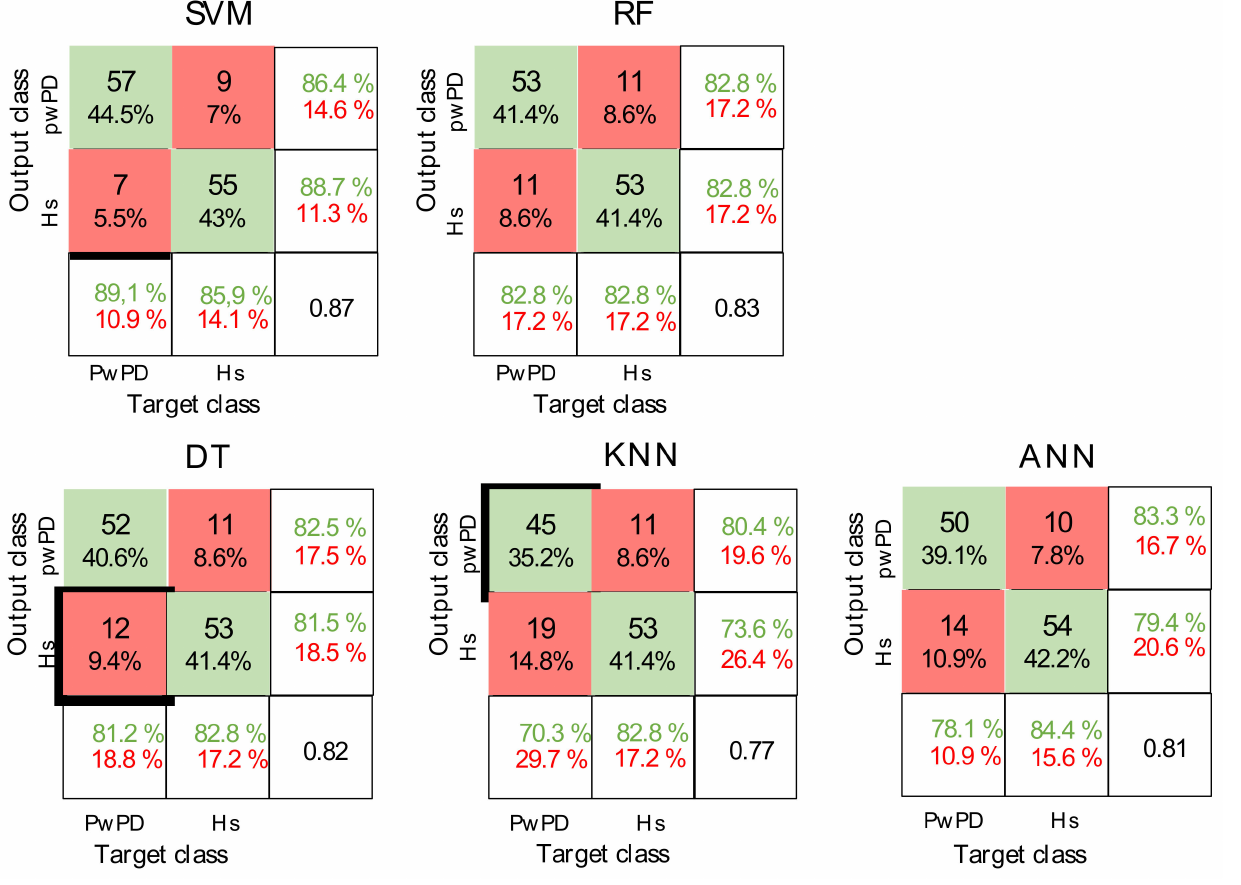
Figure 8. Confusion matrices. Representation of the confusion matrices evaluated for each algorithm after feature selection and during the run that displayed the highest accuracy value for each of them, The correct predictions are shown in green, while the wrong ones are shown in red.: PwPD, people with Parkinson’s disease; Hs, healthy subject; SVM, support vector machine; RF, random forest; DT, decision tree; KNN, K-nearest neighbor; ANN, artificial neural